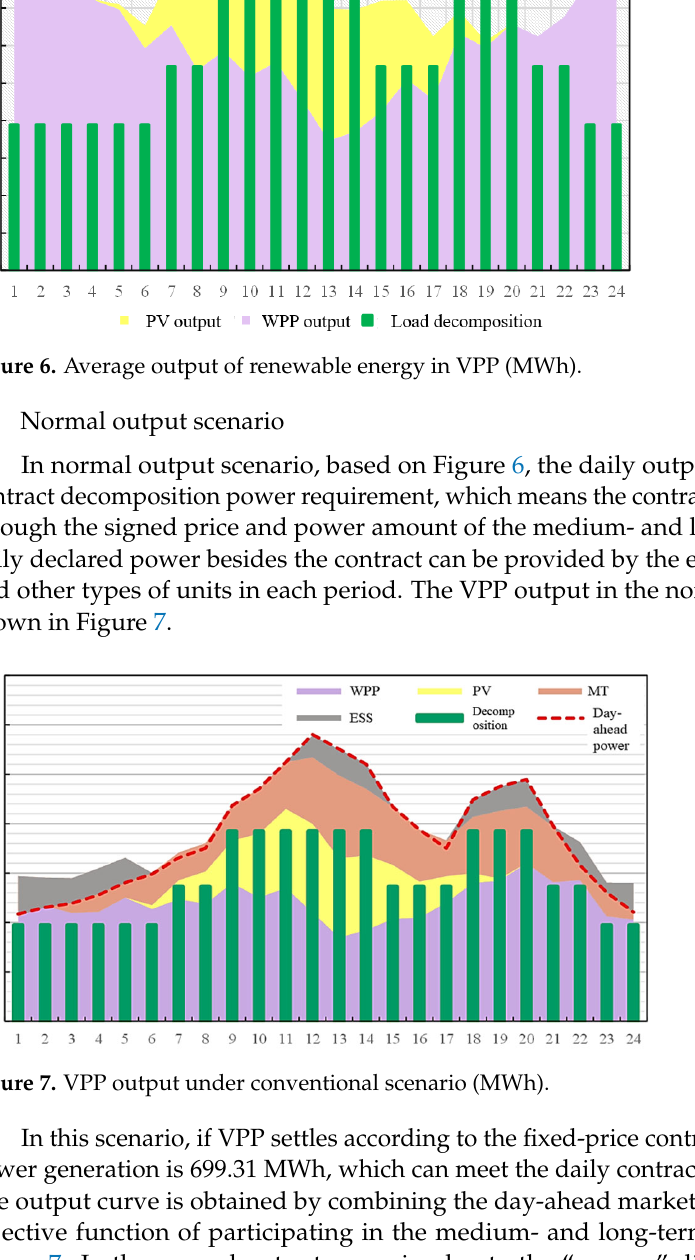
Figure 6. Average output of renewable energy in VPP (MWh).